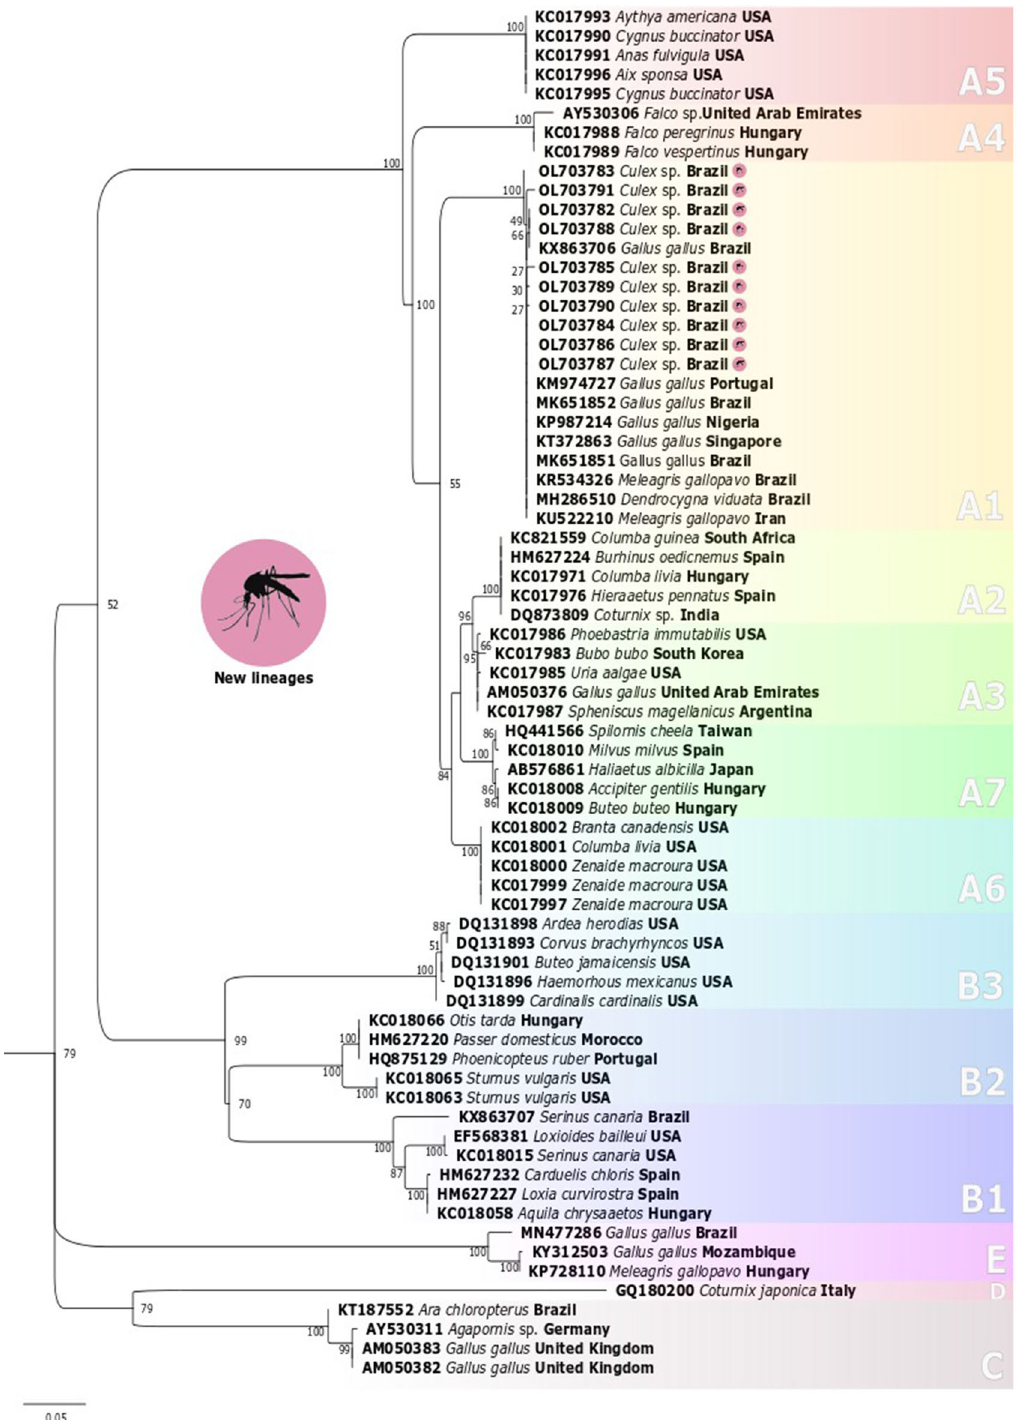
Figure 3. Phylogenetic tree estimated by the maximum likelihood method from partial p4b gene sequences of Avipoxvirus isolated in this study (highlighted) compared to sequences available in GenBank. The numbers on the branches indicate the bootstrap value out of 1000 replicates. The bar represents five substitutions per 100 nucleotide